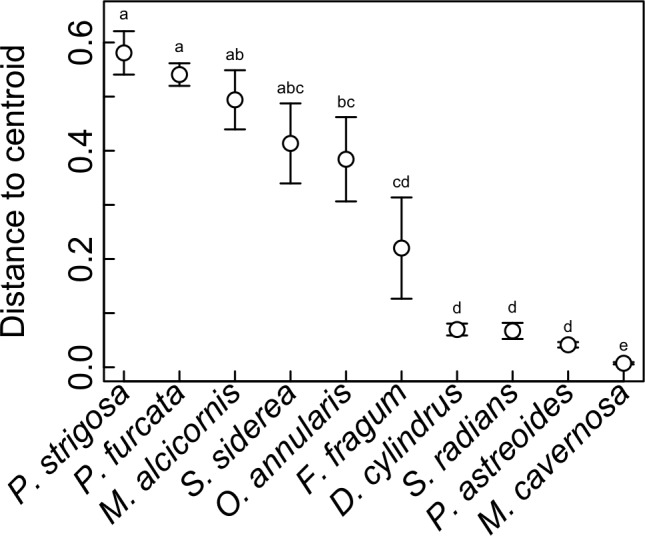
Symbiotic flexibility (beta diversity) of host species.Symbiotic flexibility in coral species quantified as multivariate dispersion of Symbiodinium community composition (mean distance to centroid) ±SE. Host taxa that do not share a letter are significantly different (p < 0.05).